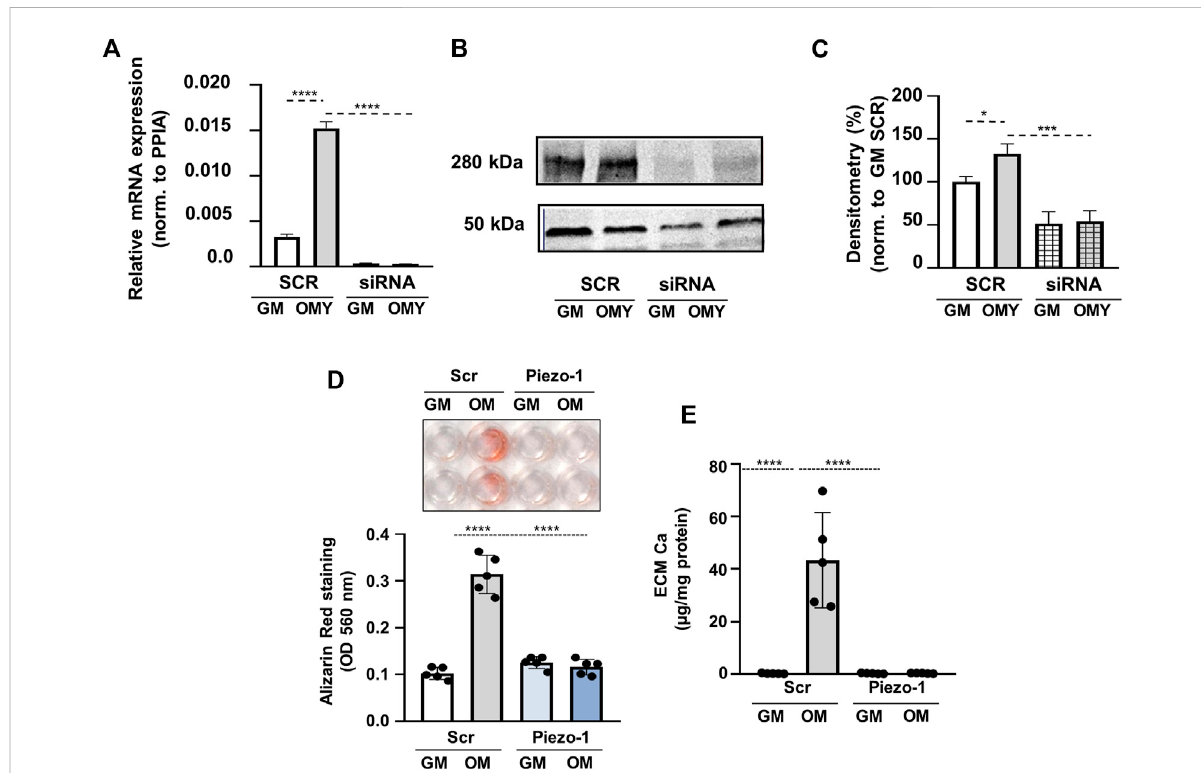
FIGURE 6 Piezo1 knockdown inhibits Yoda1-induced increase in HAoSMCs calci fi cation. (A – E) HAoSMCs were exposed to control medium (GM) or OM plus Yoda1 (OMY; excess P i : 1.5 mmol/L, excess calcium: 0.6 mmol/L, Yoda1: 10 μ mol/L) in the presence of Piezo1 targeted (siRNA) or scrambled siRNA (SCR). (A) Piezo1 expression at mRNA level acquired by qPCR under the aforementioned conditions. (B – C) Protein expression of Piezo1 in whole cell lysates (24 h). Membranes were reprobed for β -actin. Representative Western blots and relative expression of Piezo1 normalized to β -actin,respectively. (D) Representative Alizarin Red staining (day 4)and quanti fi cation. (E) Calcium content ofHCl-solubilizedECM (day 4). Data are shown as mean ± SD, n = 5 – 6. *** p < 0.005, **** p <